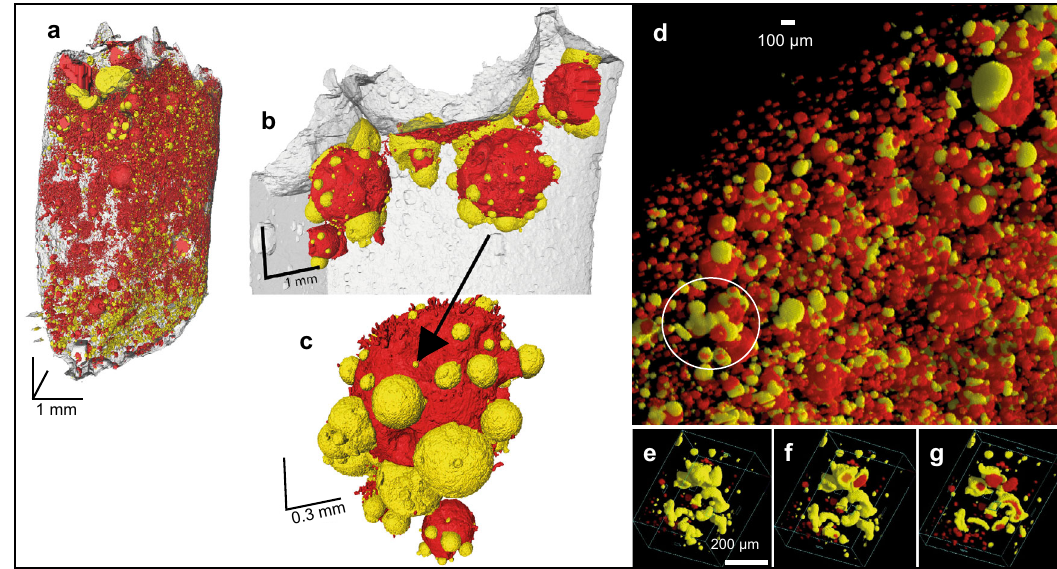
Fig. 3 HRXCT renderings of representative experimental samples. 3D distribution of sulphide droplets (in yellow) and fl uid bubbles (in red) are shown for samples MLV08 ( a – c ) and #6.3 ( d – g ). a Half of the sample, without the Pt capsule. The silicate melt is in gray and the top of the image indicates the top of the capsule. b Detailed image of the upper part of the sample. c Detailed image of compound drops showing several sulphide droplets attached to the same fl uid bubble. d Sample #6.3 that interacted with coal. The shape of the sulphide bleb in the circle strongly indicates coalescence. e Shape of the largest sulphide bleb. The fl uid phase is shown in red with the same segmented volumes of the sulphide bleb. f , g The segmented volumes of sulphide blebs are smaller than the one of fl uid bubbles, in order to hide a part of the sulphide blebs and to show the bubbles occurring at their interior.